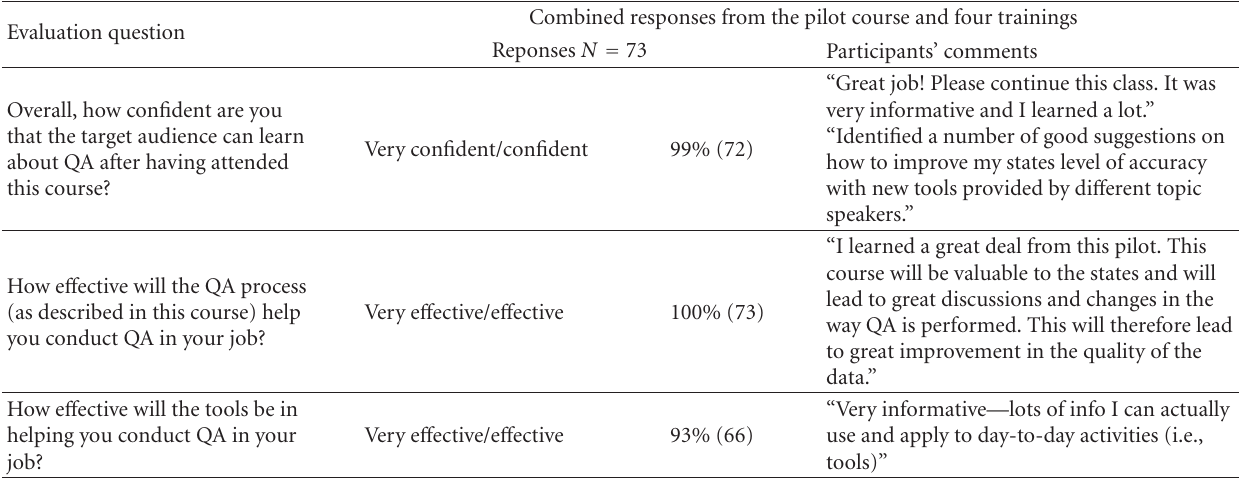
Table 3: Combined evaluation results of the quality assurance training courses, Centers for Disease Control and Prevention, July–September